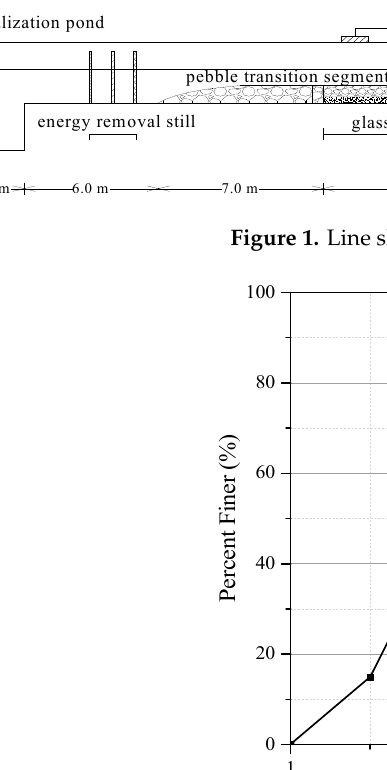
Figure 2. Grain size distributions of the initial bed surfaces materials.